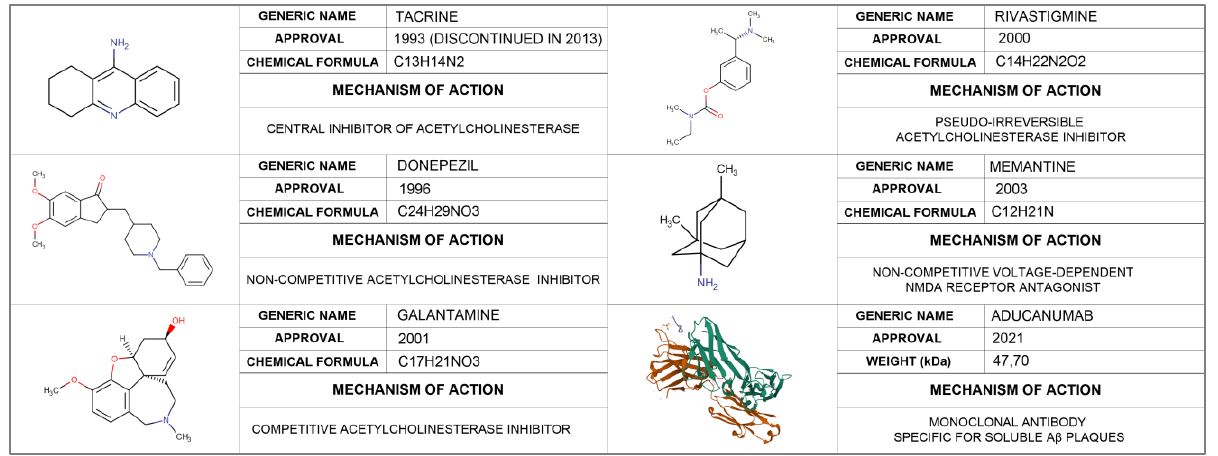
Figure 1. Drugs approved for the treatment of Alzheimer’s disease: mechanisms of action, weight, and molecular